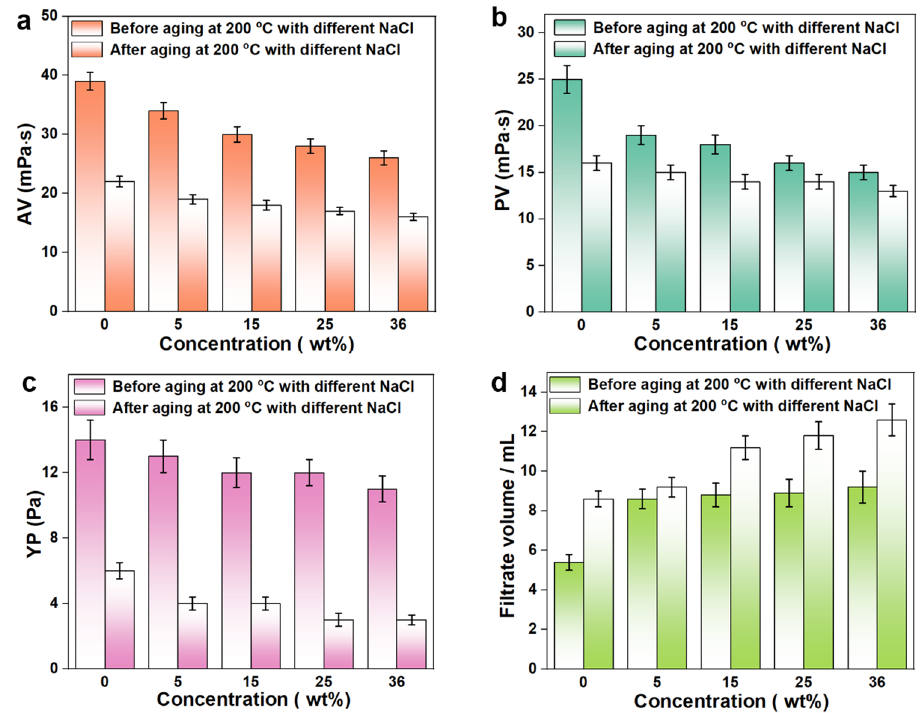
Figure 5. Rheological and fluid loss properties of 2 wt% NS-ANAD-based drilling fluids with different fractions of NaCl before and after aging at 200 °C for 16 h: ( a ) apparent viscosity (AV); ( b ) plastic viscosity (PV); ( c ) yield point (YP); ( d ) fluid loss volume (FL API ).